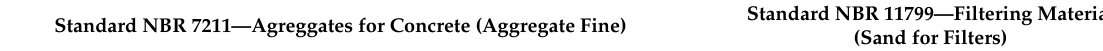
Figure 9. Survey 2 size distributions and limits for use as sand for concrete. Table 9. Survey 2 product analysis.